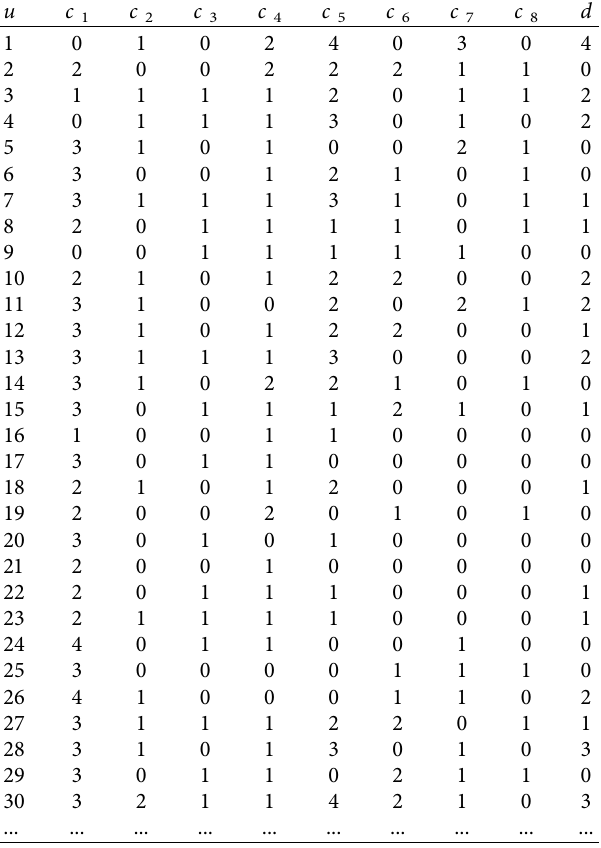
Table 8: Discretization results of attributes.